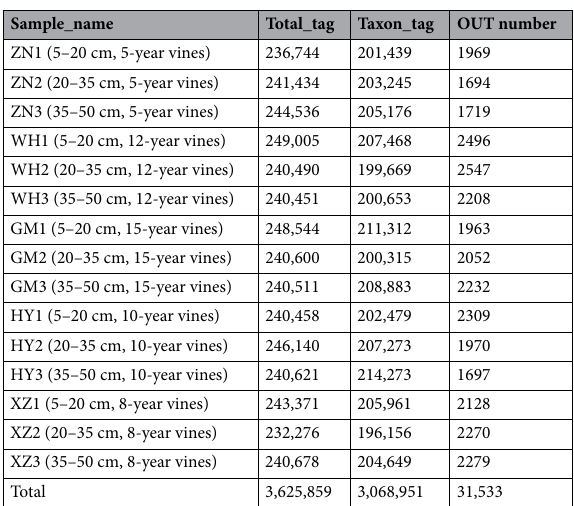
Table 3. Sequence number and OTU number of soil samples.